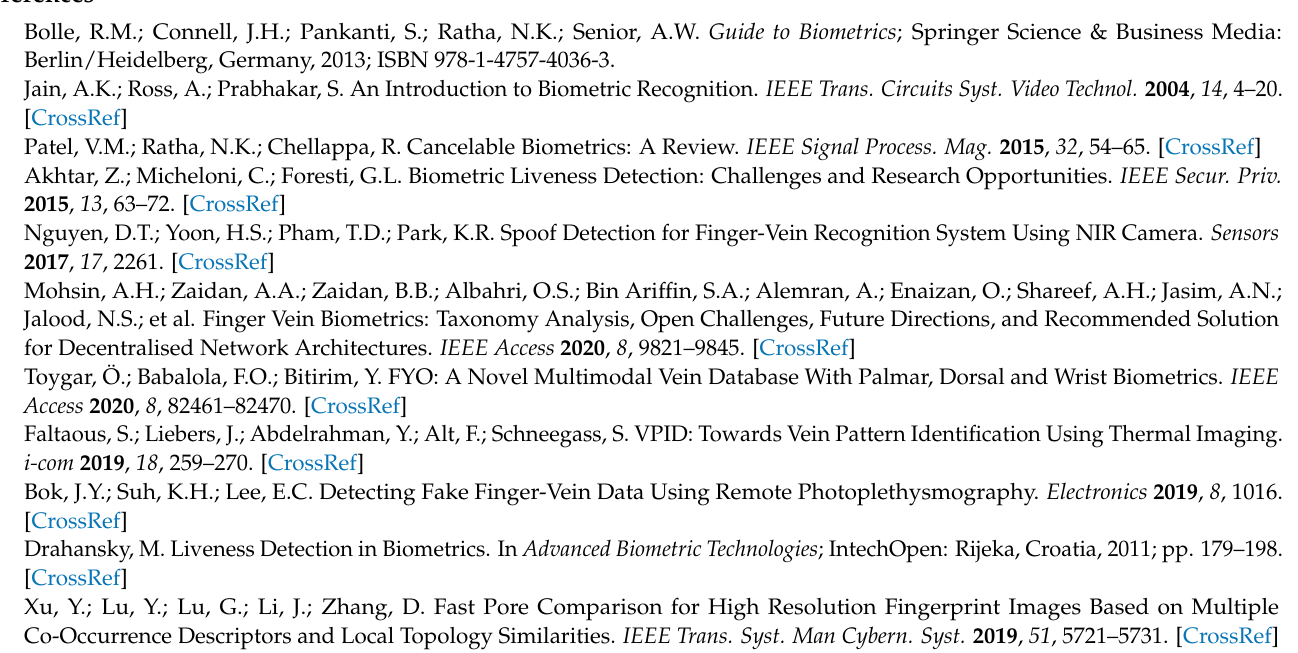
each frequency. Table S1: Comparison of performance for four models according to the number of channels. Table S2: Identification accuracy in the rf model according to finger channel combination. Table S3: Average classification accuracy of each frequency section. Table S4: Classification accuracy with the increasing number of